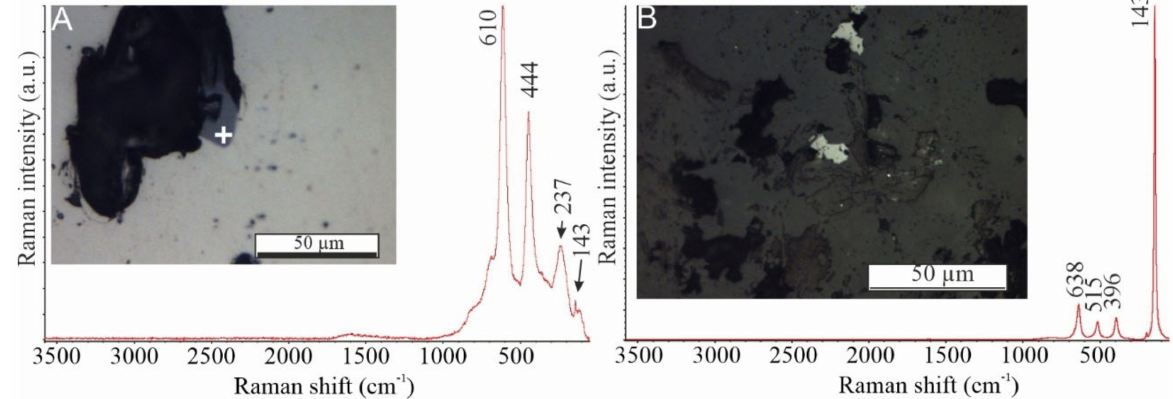
Figure 6. Raman spectra of Ti-bearing inclusions in Py-III: rutile ( A ); anatase ( B